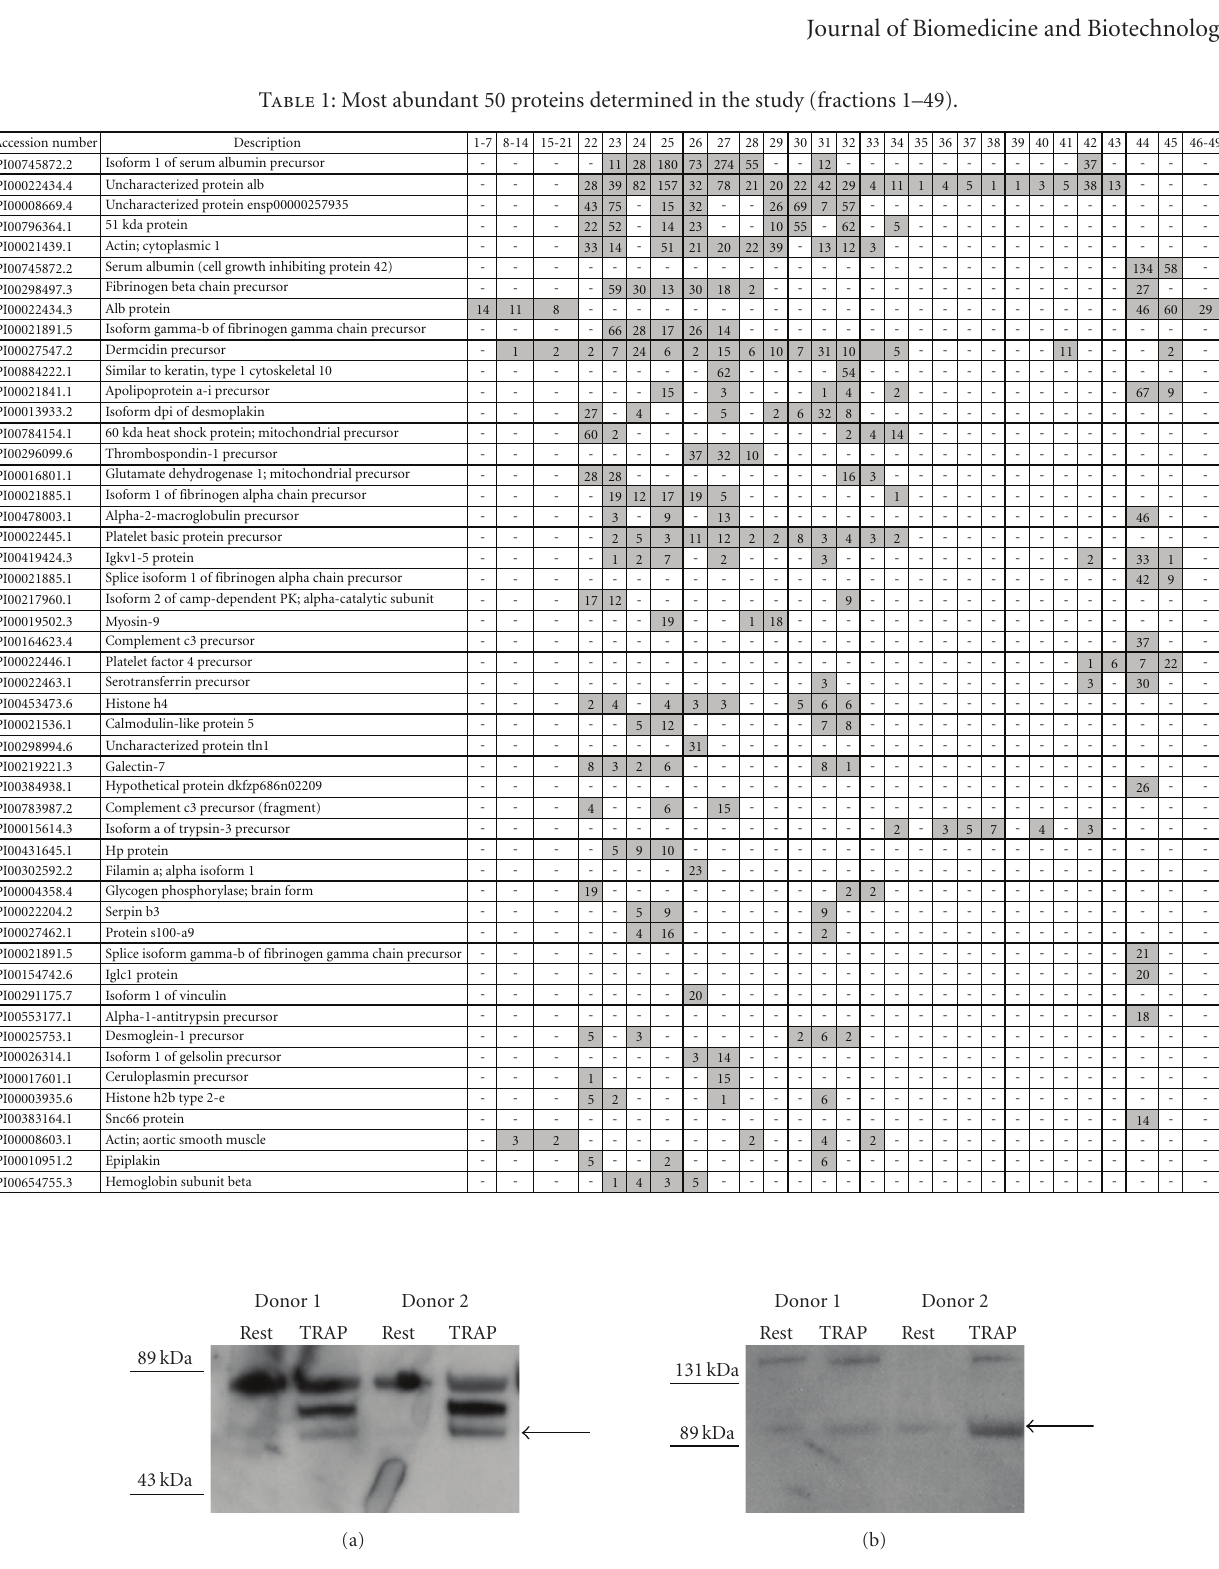
Figure 5: Western blot validation of novel platelet proteins. 30 μ L of resting and TRAP-stimulated platelet releasate were separated on a 4%–20% gradient SDS-PAGE gel and probed for PEDF and involucrin. (a) PEDF was detected as a band at approximately 50 kDa, with additional heavier bands that may represent glycosylated forms of the protein. (b) Involucrin was detected at the expected molecular weight as a band resolving at approximately 120kDa. The locations of molecular weight markers are also indicated. These proteins were identified in TRAP-stimulated platelet releasates from 4 individual donors. Images displayed are representative of the 4 individual donors. R = Resting/unstimulated platelet releasate T = TRAP-stimulated platelet